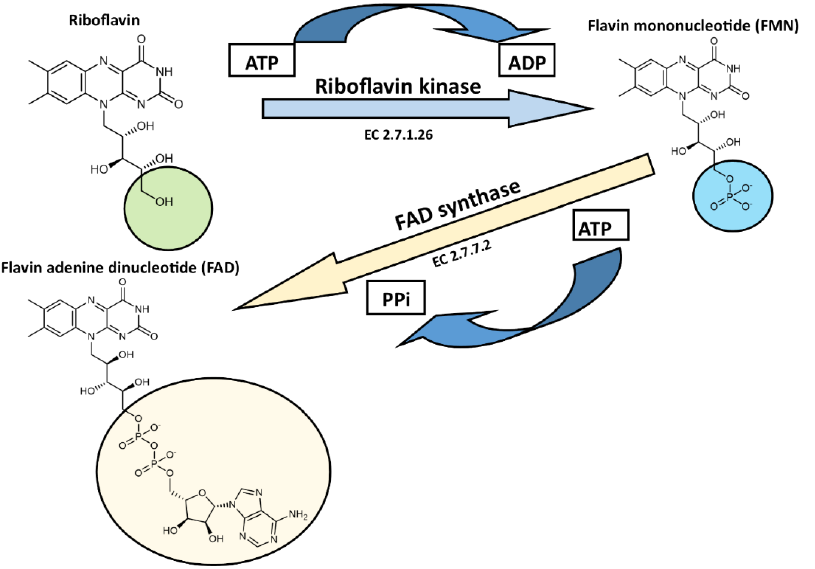
Figure 8. Cofactor biosynthesis. After penetration to the cells by facilitated transport mechanism, riboflavin is transformed into its biologically active forms by 2 cytosolic enzymes, riboflavin kinase and FAD synthase. ATP—adenosine triphosphate, ADP—adenosine diphosphate, PPi—pyrophosphate. See text for detailed description.